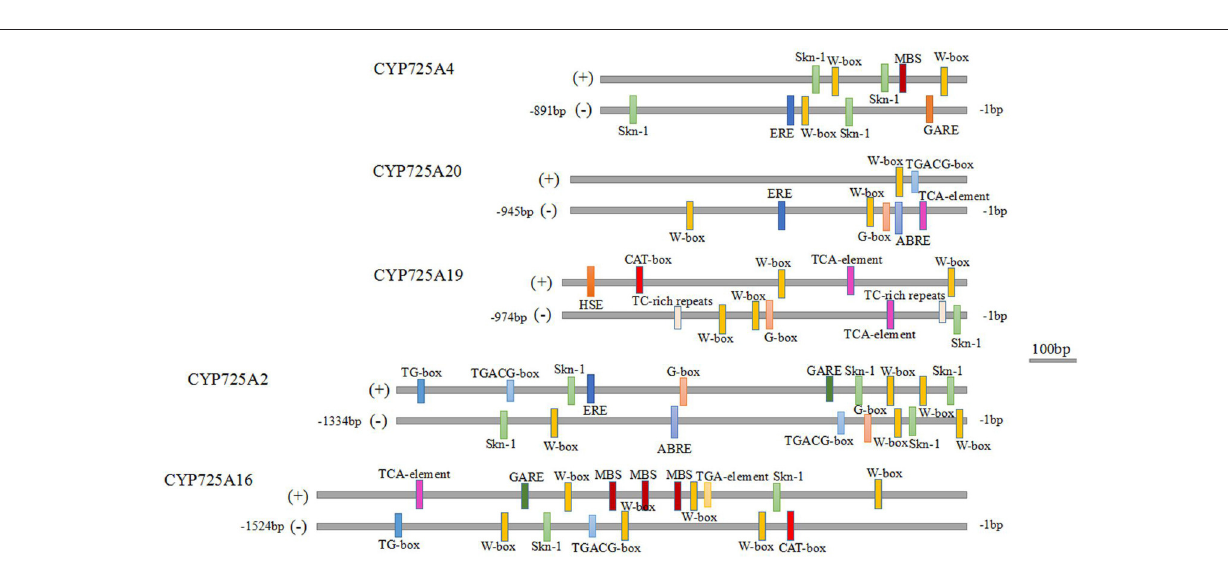
FIGURE 8 | Cis-acting elements in the promoter regions of CYP725 genes. The scale bar represents 100